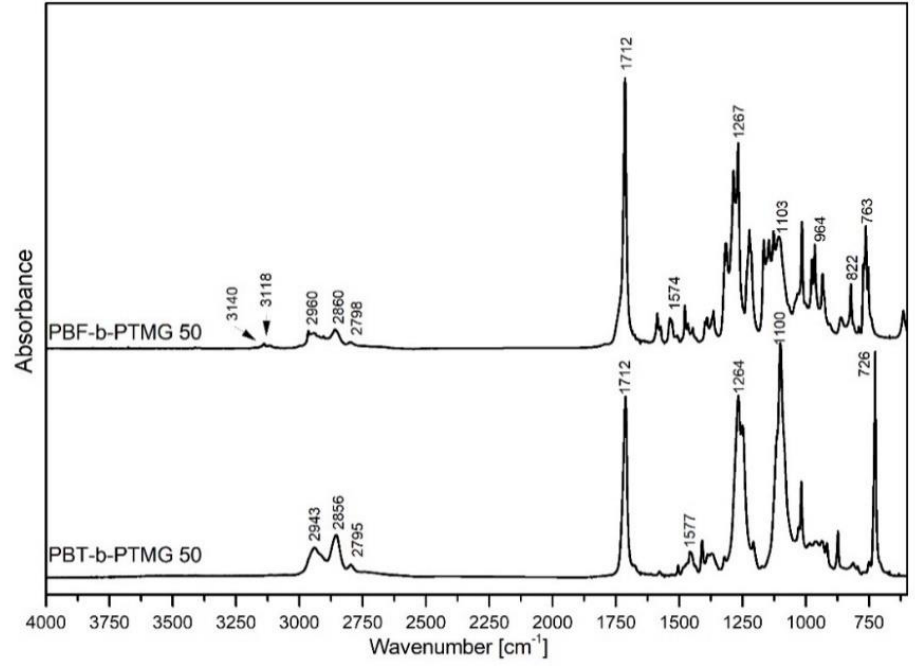
Figure 2. FTIR spectra of PBF and PBT copolymers.